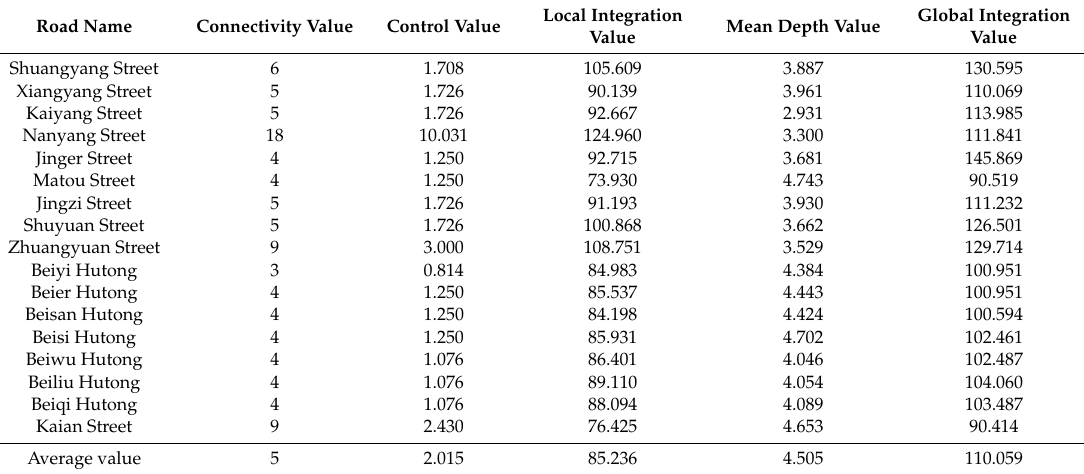
Table 3. Space syntax analysis variables of ancient town area in